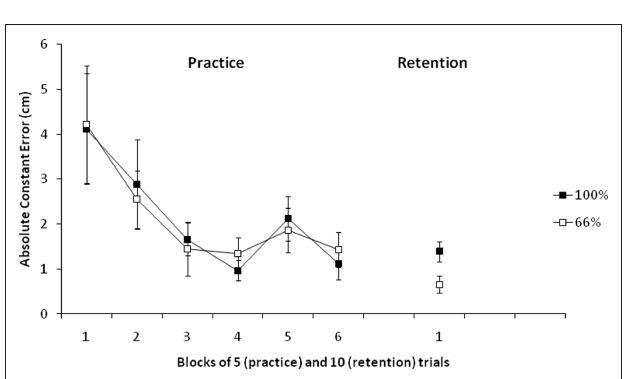
Figure 2 | Constant error scores of the 100 and 66% Kr groups in practice and retention. (Error bars represent SE.)